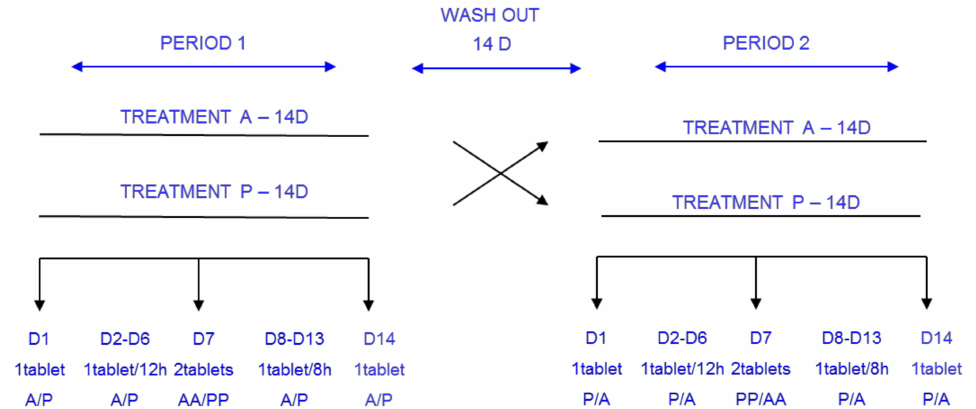
Figure 1. Study procedures schema (A: Active treatment (carisoprodol); P: Placebo; AA: double active treatment dose (carisoprodol 700 mg); PP: double placebo